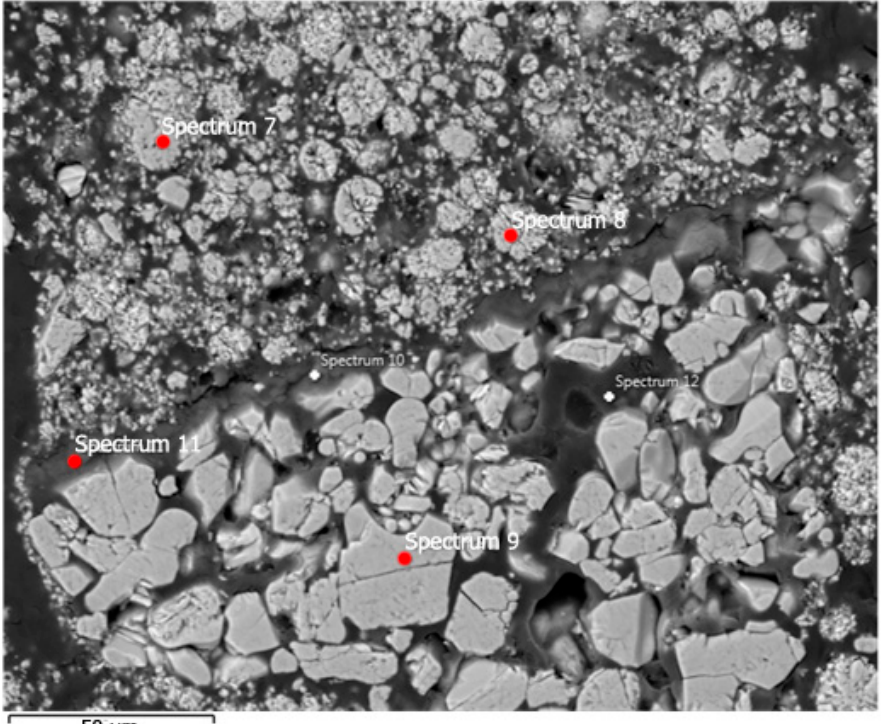
Figure A1. Spectrum locations identified for phase composition analysis. Table A1. Metal weight percentage of identified spectrums.